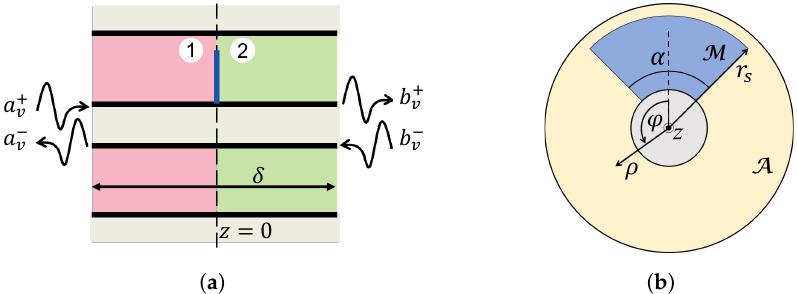
Figure 3. Cross-sectional views of the sub-unit cell in the: ( a ) longitudinal plane and ( b ) transversal plane at the position of the